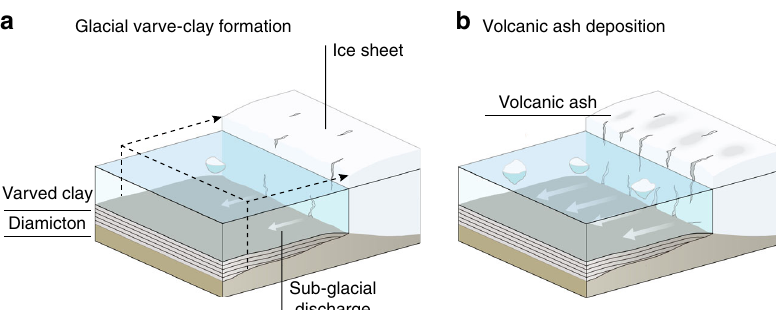
Fig. 3 Illustration showing the formation of glacial varved clay in response to volcanic eruptions during the last deglaciation of the Fennoscandian Ice Sheet. a Melting of the ice in the ablation zone of the ice sheet during the summer season contributes large volumes of subglacial meltwater with high sediment load to the Baltic Ice Lake. This results in lake-bottom currents and deposition of fi ne sand and silt layers. The clay layer formed in winter when lake ice covered the Baltic Ice Lake. The two layers or couplets are thus associated with the melting and non-melting season, respectively, and form one varve. b Volcanic eruptions result in ash deposition on the ice-ablation zone, which enhances melting and thus subglacial sediment discharge by lowering the